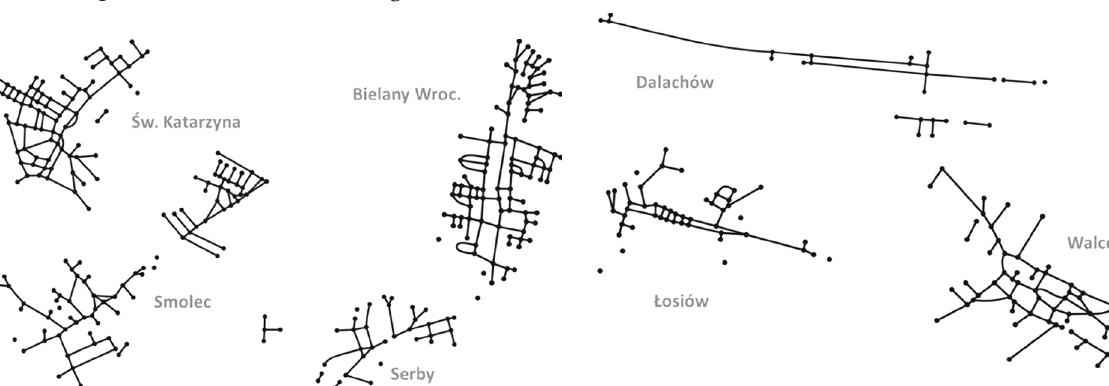
Fig. 14. Graphs depicting the morphology of lowland villages with the population ranging from 1,000 to 2,500 inhabitants (LV1-LV6). Source: own